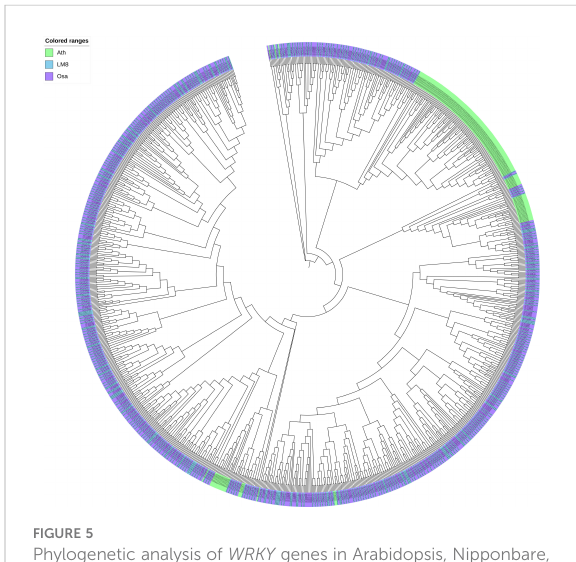
FIGURE 5 Phylogenetic analysis of WRKY genes in Arabidopsis, Nipponbare, and LM8. Ath, Arabidopsis thaliana ; Osa, Oryza sativa . Nipponbare was selected as a typical cultivated rice variety, whereas Ath and Osa served as